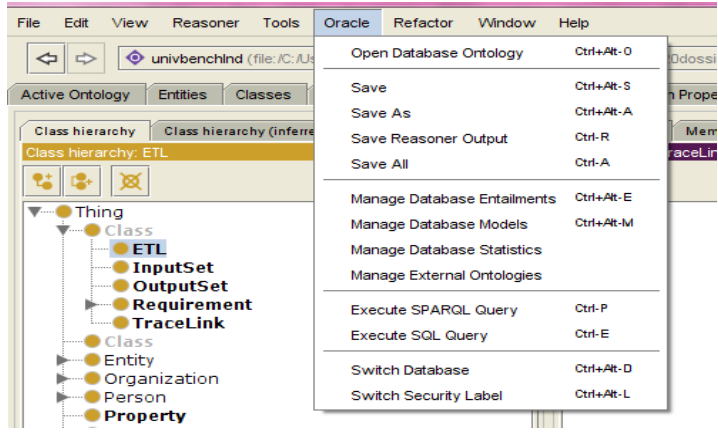
Figure 5. Protege plugin for the Oracle semantic database management system